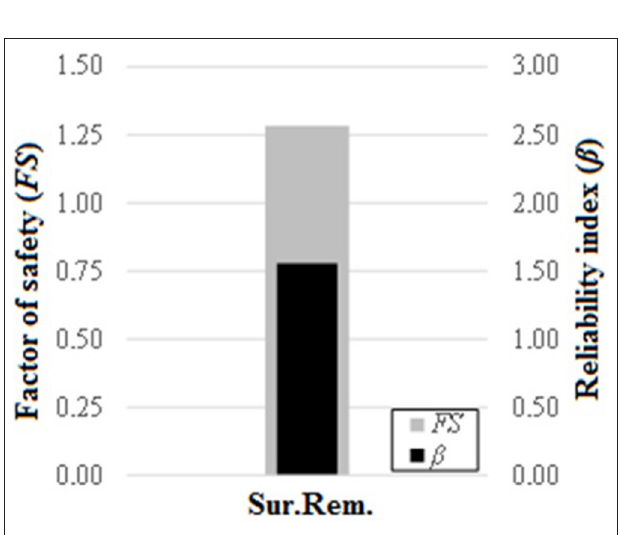
FIGURE 7 | Deterministic and probabilistic results for the three-dimensional analysis (SLIDE 3